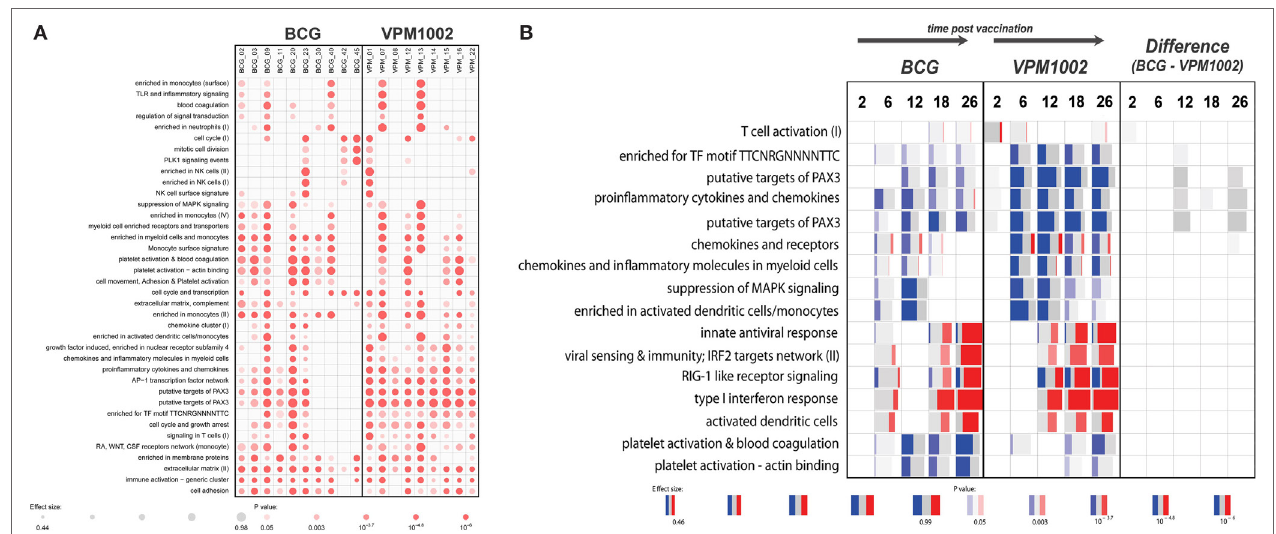
FiGURe 1 | Gene set enrichment results generated with the tmod R package. (A) Enrichment in gene modules in each individual at 26 weeks postvaccination compared with baseline. (B) Gene set enrichment in both groups and between the groups at different time points compared with baseline. Red and blue indicate the proportion of genes in a particular module that is upregulated or downregulated respectively. Width of each box relates to its effect size, while brighter colors indicate lower p -values. Panel (B) represents a selection of a larger number of enriched gene